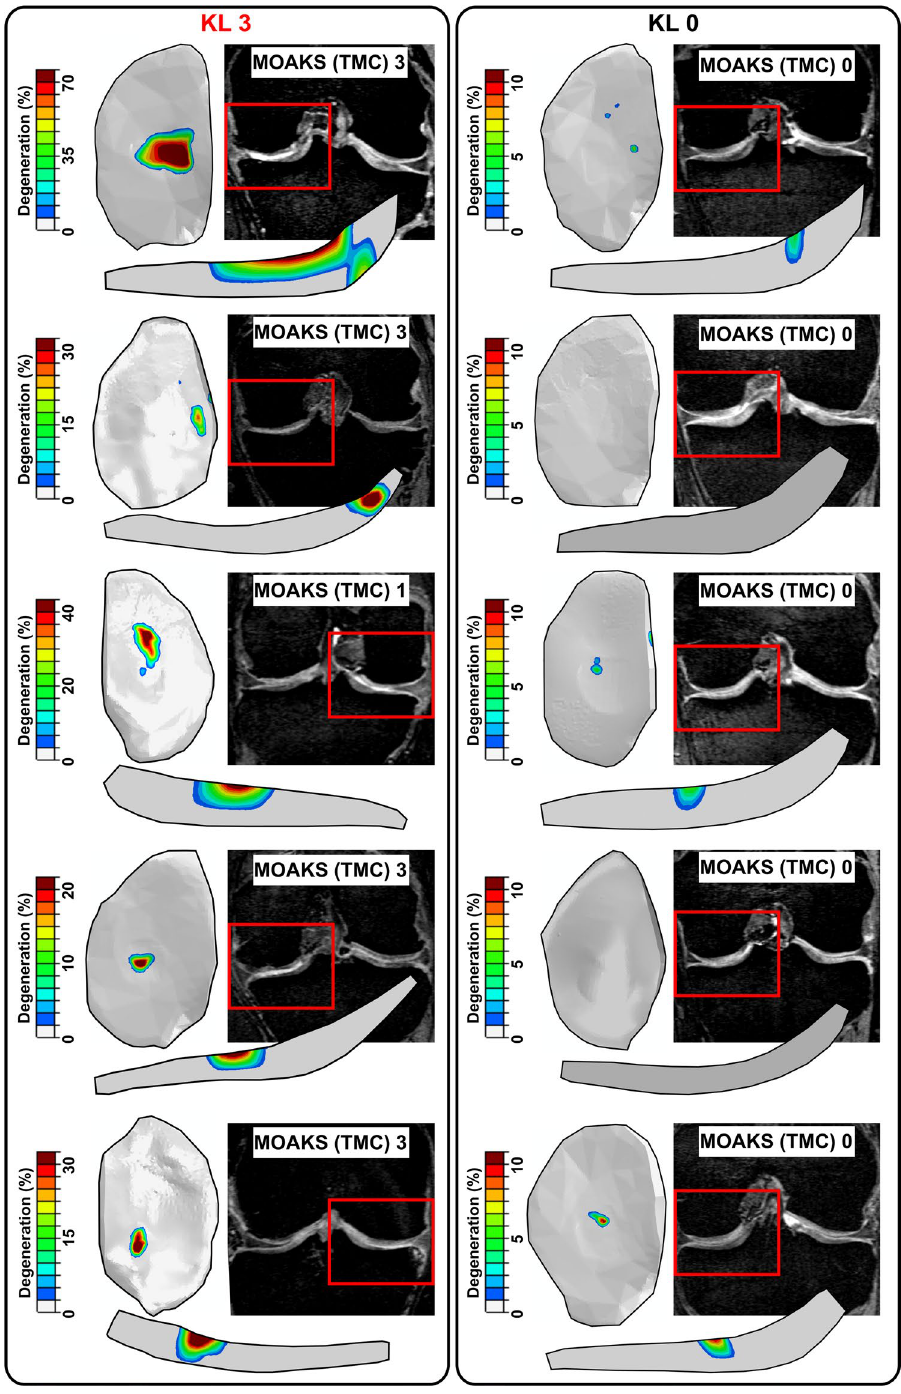
Figure 3. Cartilage degeneration distributions and MRI MOAKS grades for five selected KL3 and KL0 subjects. MOAKS grades are from central part of medial tibial cartilage (TMC = tibia medial